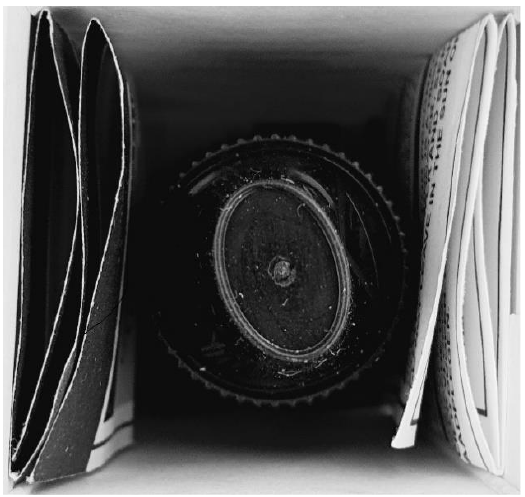
Figure 2. The placing of the EU’s new e-cigarette leaflet inside an e-liquid packet.